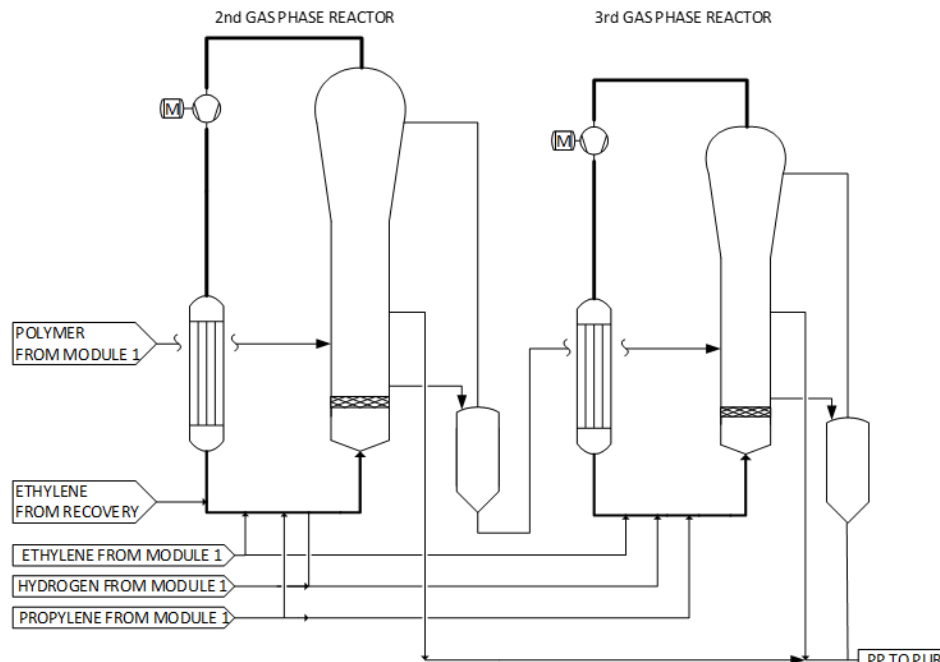
Figure 3. Simplified schematic flow diagram of reactor module 2 of the Borstar ® PP process.